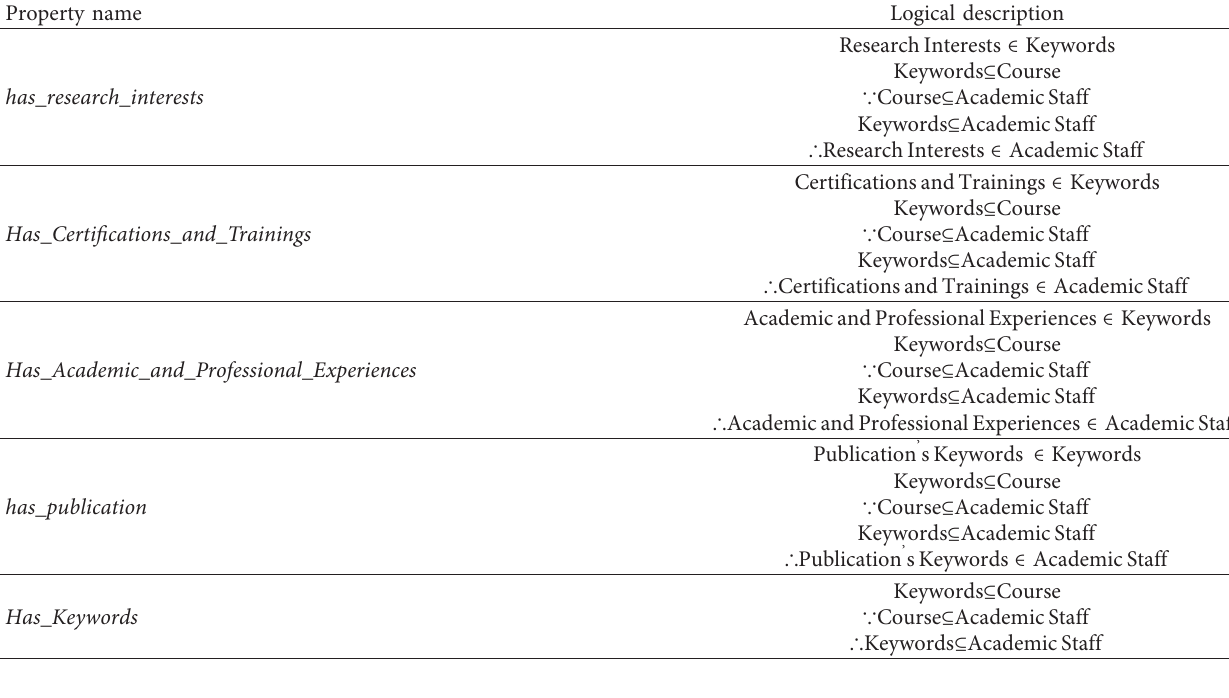
Table 2: Related_to property mechanism.